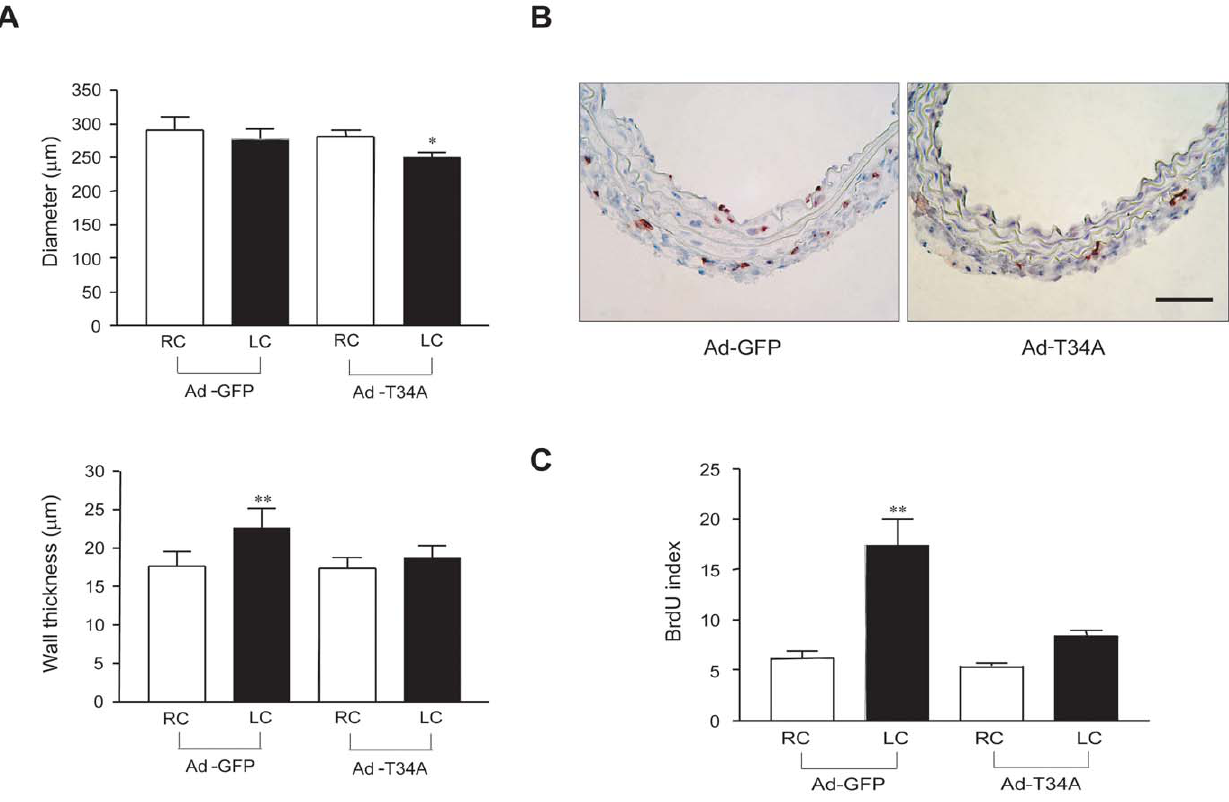
Figure 4. Ad-T34A survivin transduction blocks cell proliferation and restores normal remodeling in eNOS ( 2 / 2 ) mice. (A) LCs were transduced with Ad-GFP or Ad-T34A survivin at the time of LEC ligation. Lumen diameter and wall thickness were calculated from 10 sections of contralateral RC and infected LC of eNOS ( 2 / 2 ) mice. Upper panel shows lumen diameter of Ad-T34A transduced LC was significantly decreased compared to RC. Ad-T34A transduction also blocks the wall thickening in transduced LC (lower panel). (B), Ad T34A suvivin reduces the number of BrdU positive cells in LC. (C), BrdU labeling index shows significant increase of BrdU positive cell/total nuclei ratio in Ad-GFP transduced LC compare to RC in eNOS ( 2 / 2 ) mice. This activation of cell proliferation was blocked by Ad-T34A transduction. Values are mean 6 SEM; * P , 0.05, ** P , 0.01, and { P , 0.001 with one way ANOVA with Bonferroni posttest; n=5 for each group of mice. Scale bar equals to 25 m m.